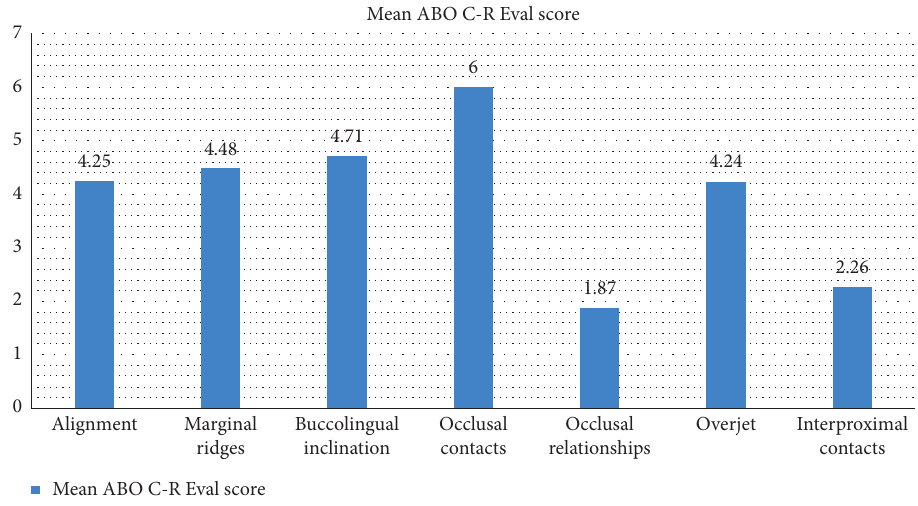
Figure 2: Average ABO OGS score per cast parameter. Table 5: Bivariate analysis of treatment outcomes and categorical variables.